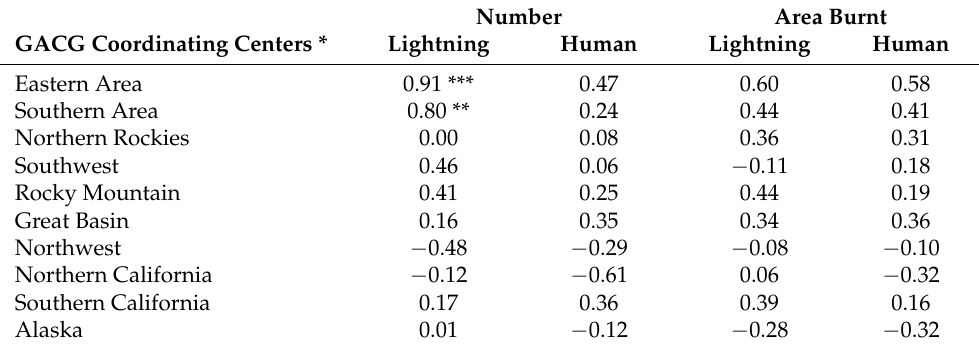
Table 3. Spearman correlation coefficients of monthly 8-h max O 3 concentrations and lightning, the number and area burnt by human-induced wildfires in regional GACG coordinating centers.